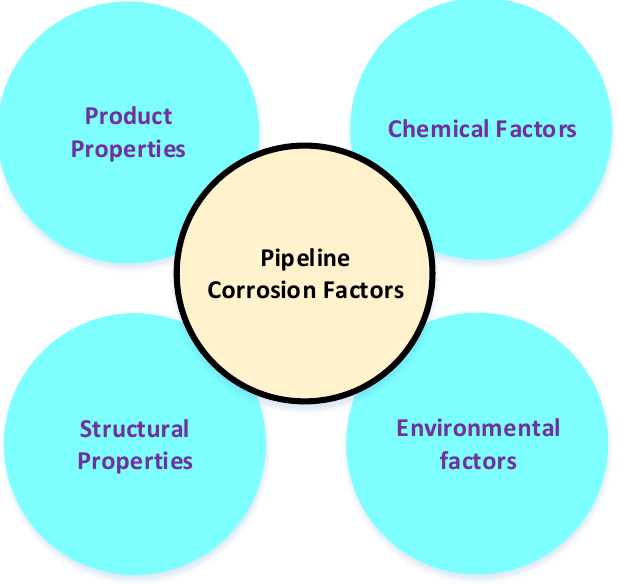
Figure 2. The causes of pipeline